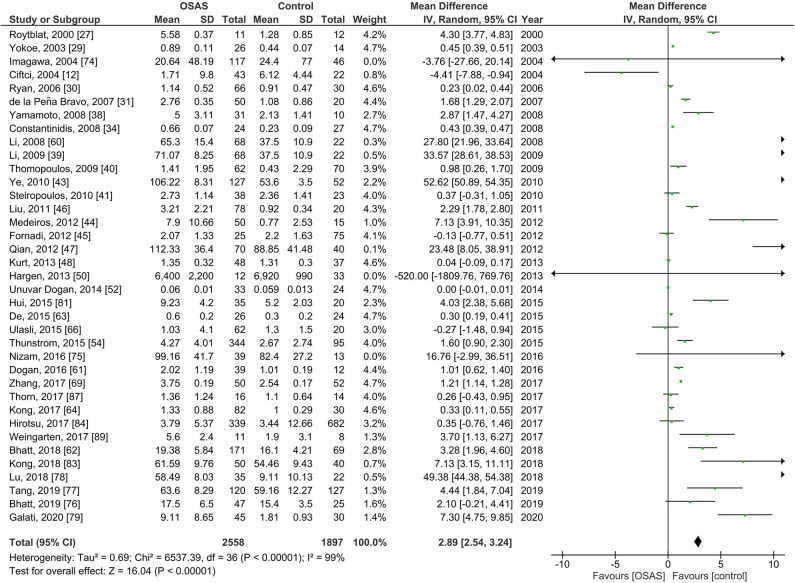
Forest plot of random-effects analysis of serum interleukin-6 levels in adults. The diamond shape indicates the pooled mean difference (MD). Each black box represents a point estimate of each study and also gives a representation of the study size (the bigger the box, the more participants in the study). A horizontal line representing the 95% confidence intervals (CIs) of the study result, with each end of the line representing the boundaries of CI. SD, standard deviation; OSAS, obstructive sleep apnea syndrome.